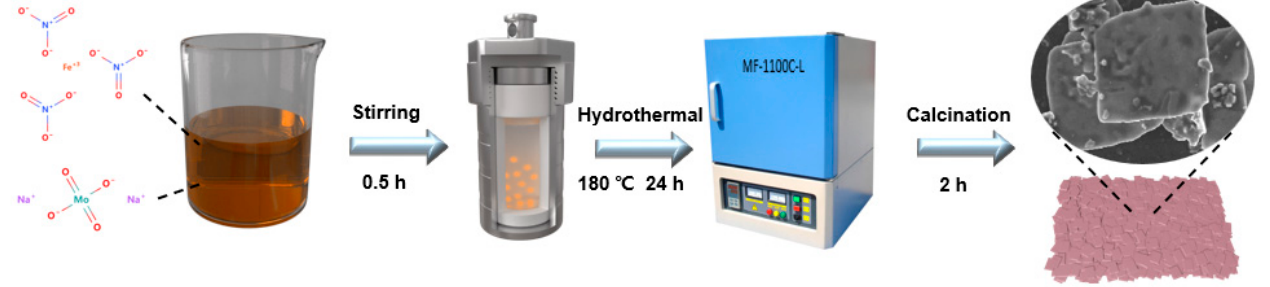
Figure 8. Preparation process for FMO.